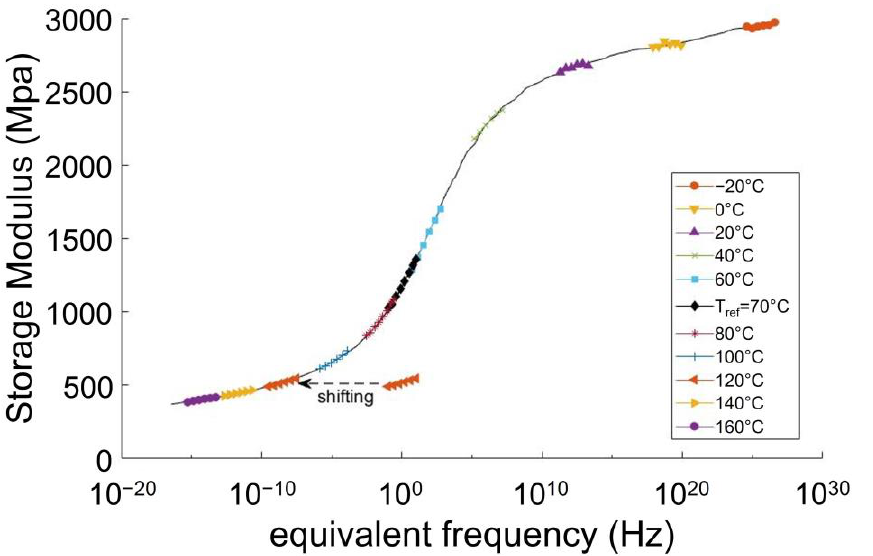
Figure 14. Illustration of some frequency scans used for building a master curve. Example of a dry unaged PA66. For better readability, only a few temperatures are displayed.